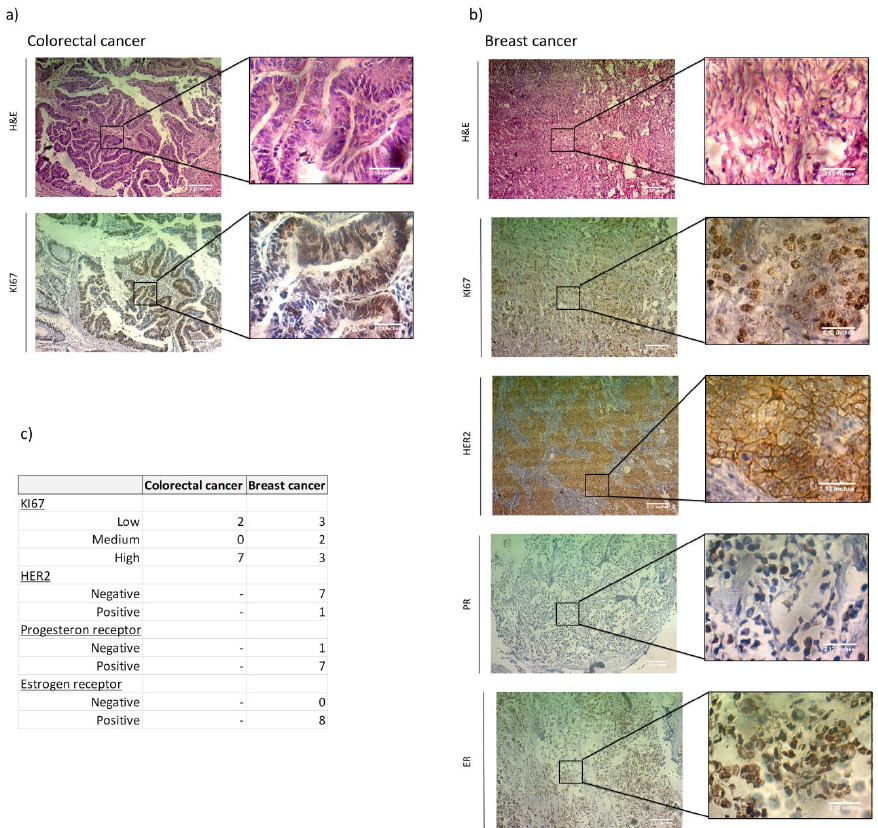
Figure 1. Immunohistochemical analysis of ER, PR, HER2 and KI67 in tumor tissue of colorectal and breast cancer patients. Representative images of positive ER, PR, HER2 and KI67 staining. Magnification 100× and 400×. ( a ) H&E and KI67 staining in colorectal cancer tissue. ( b ) H&E, KI67, HER2, PR and ER positive staining in breast cancer tissue. ( c ) Summary of the IHC staining results. The table shows the number of patients in each category. Dash shows a category that was not